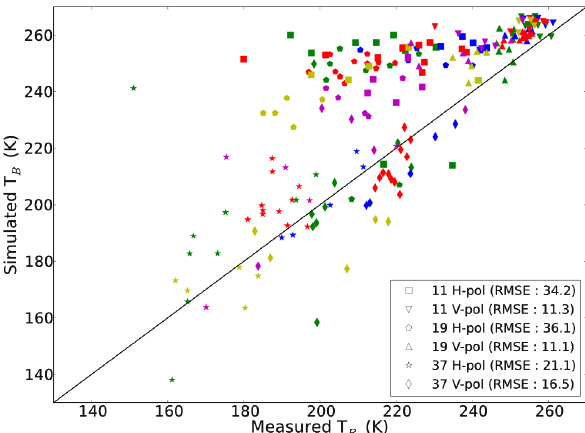
Figure 5. T B simulated without ice lenses in DMRT-ML and bridg- ing. RMSE (K) between measured and simulated T B are given in parentheses. The symbol types correspond to the frequency and col- ors to the sites: red is JB Jan-transect ; green is JB Jan-others ; blue is JB Feb ; yellow is JB Mar ; magenta is